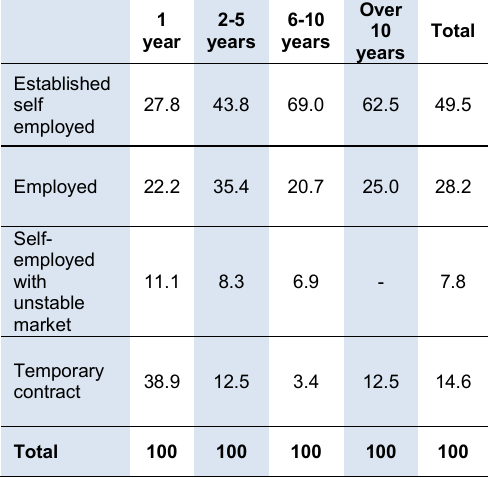
Table 3- the participants' position in the job market. Analysis per year of graduation n = 98.